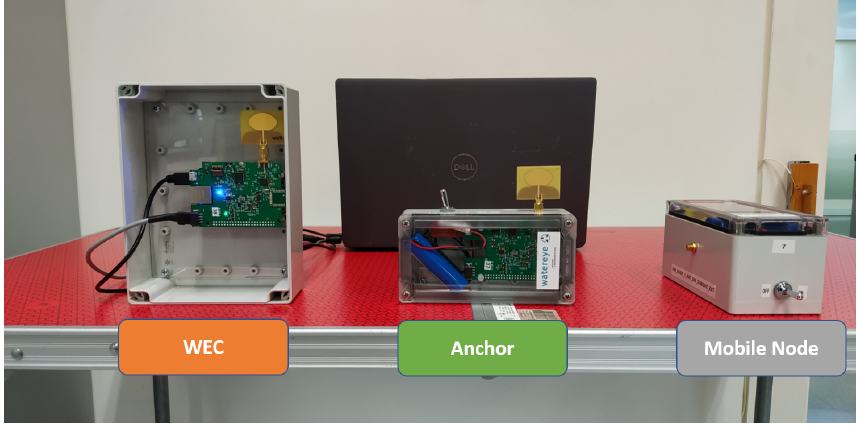
Figure 15. Implemented setup for the coverage